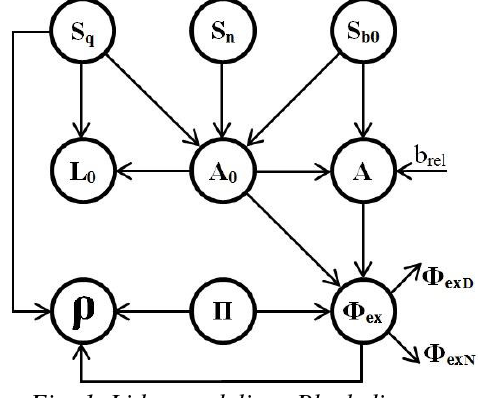
Fig. 1. Lidar modeling: Block diagram of relationships between system